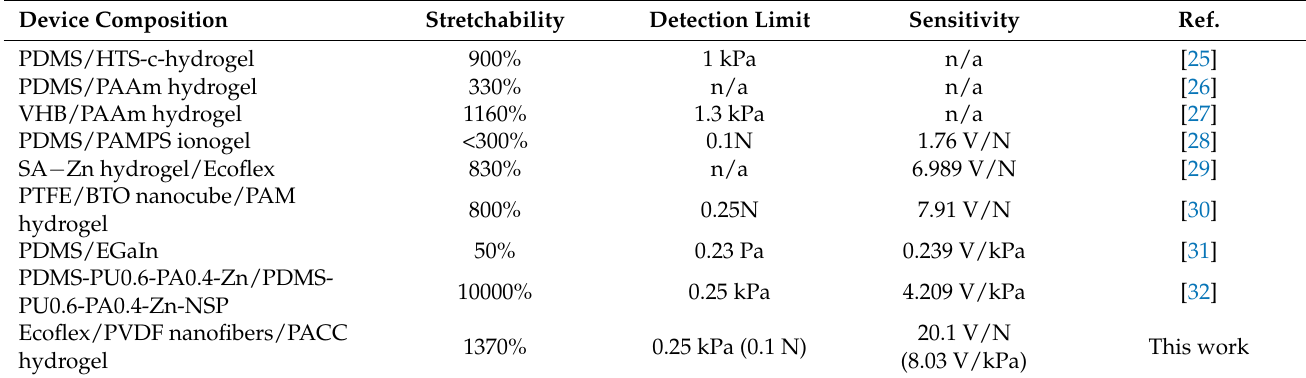
Table 1. Comparison of the reported stretchable triboelectric devices.